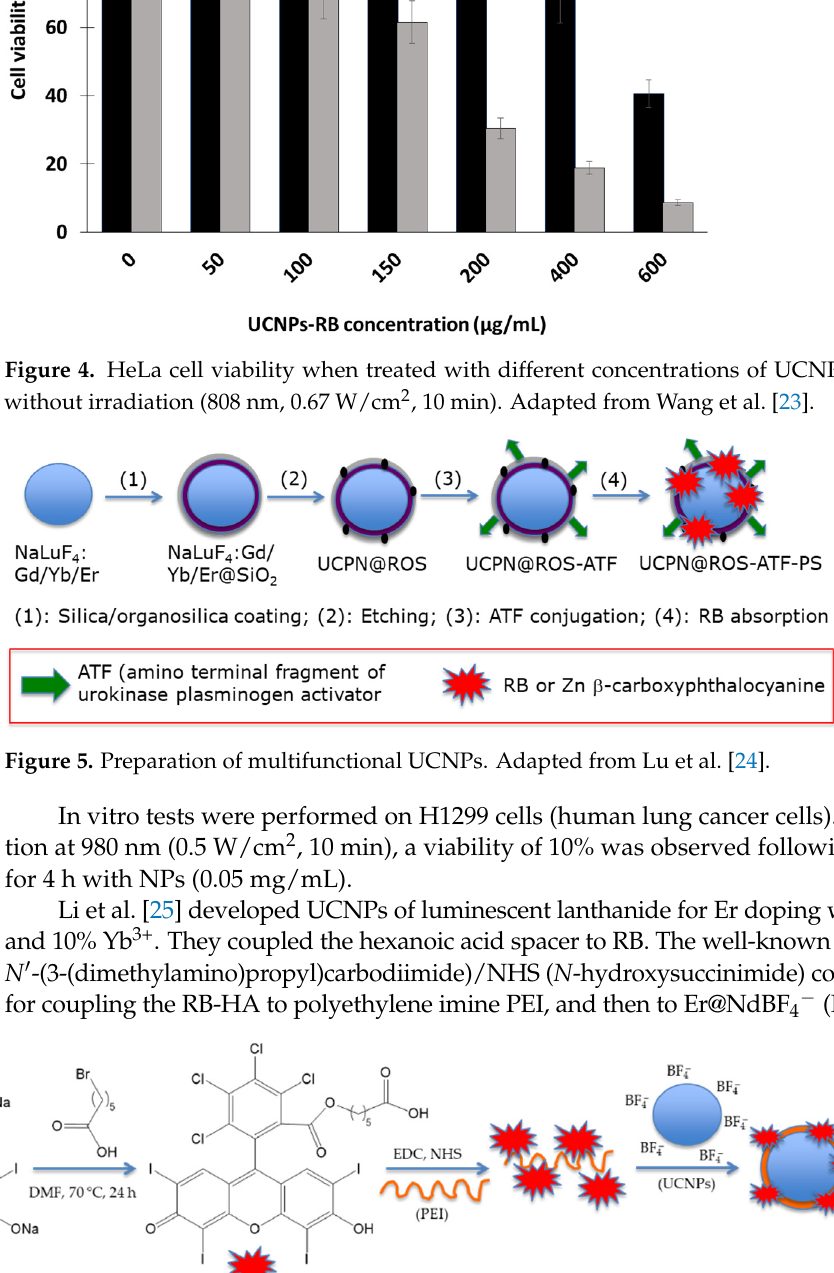
nelle membranes. Figure 7. In vitro PDT of Er@Nd-RB. Cell viability of 4T1 cells with different ( a ) concentrations, ( b ) laser power densities, and ( c ) irradiation times. Adapted from Li et al. [25]. The in vivo tests were performed on 4T1 breast cancer in BALB/c nude mice. Follow- ing 808 nm laser irradiation (520 mW/cm 2 ), Er@Nd-RB conjugates rapidly set upon the tumor region and remained at the tumor site for at least 45 min, while no signal was de- tected in other parts of the body. Mice treated with Er@Nd-RB NPs (100 µL, 10 mg/mL) showed a greater decrease in tumor volume compared to the control with other NPs (Fig- ure 8a).